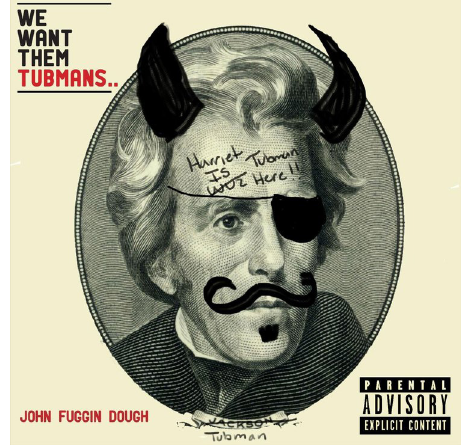
Figure 2. Cover art for John Fuggin Dough’s Tubmans